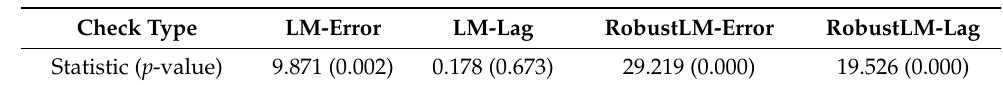
Table 6. Statistics of LM test results.